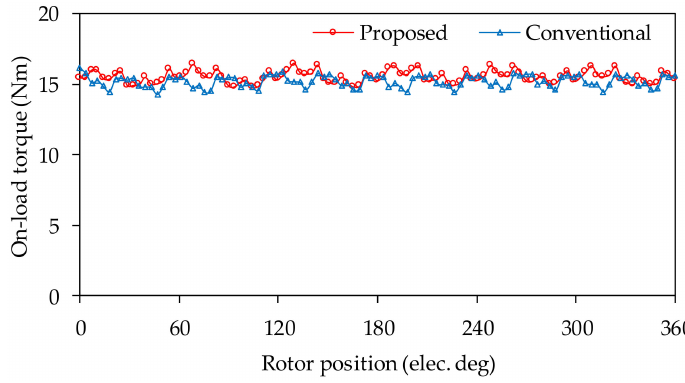
Figure 15. On-load torque waves of the two compared